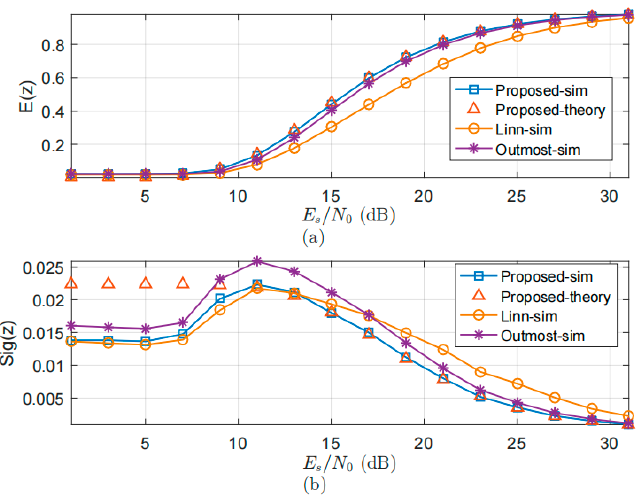
Figure 4. Expectation and variance versus SNR under the condition that carrier synchronization is locked for the 16APSK signal: ( a ) expectation; ( b ) variance.